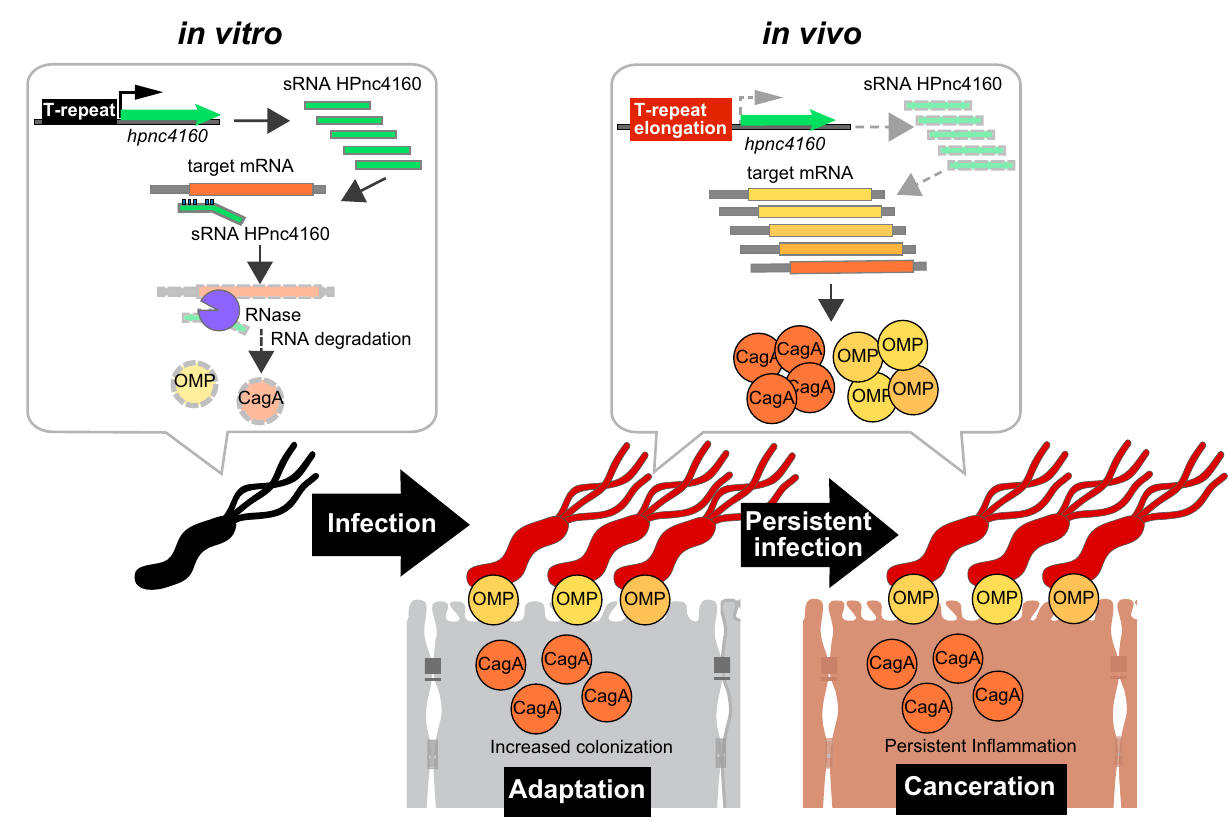
Fig. 7 Infection-induced silencing of HPnc4160 upregulates target gene expression and promotes bacterial-host adaptation and, potentially, oncogenesis during chronic H. pylori infection. H. pylori infection in vivo leads to elongation of T-repeats upstream of the HPnc4160 sRNA coding region, which results in decreased expression of HPnc4160 sRNA. Gene silencing of HPnc4160 results in increased target gene expression, coding for OMPs and CagA. As a result, bacterial colonization and CagA translocation into the attached host cells increase, promoting bacterial adaptation to the host and, possibly,